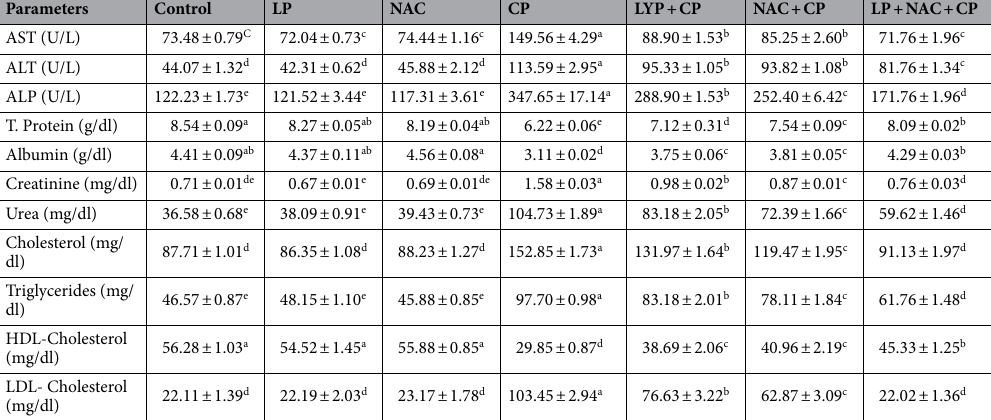
Table 1. Effects of LP, NAC, and/or CP on serum biochemical parameters (n = 7). Data are expressed as the mean ± SE (n = 7). Different superscript letters in the same row indicate statistical significance at P ≤ 0.05. Cisplatin (CP) at a single dose of 7.5 mg/kg (IP); lycopene (LP) at a dose of 10 mg/kg; N-acetylcysteine (NAC) at a dose of 150 mg/kg; aspartate aminotransferase (AST); alanine aminotransferase (ALT); alkaline phosphatase (ALP); high density lipoprotein (HDL); low density lipoprotein (LDL).